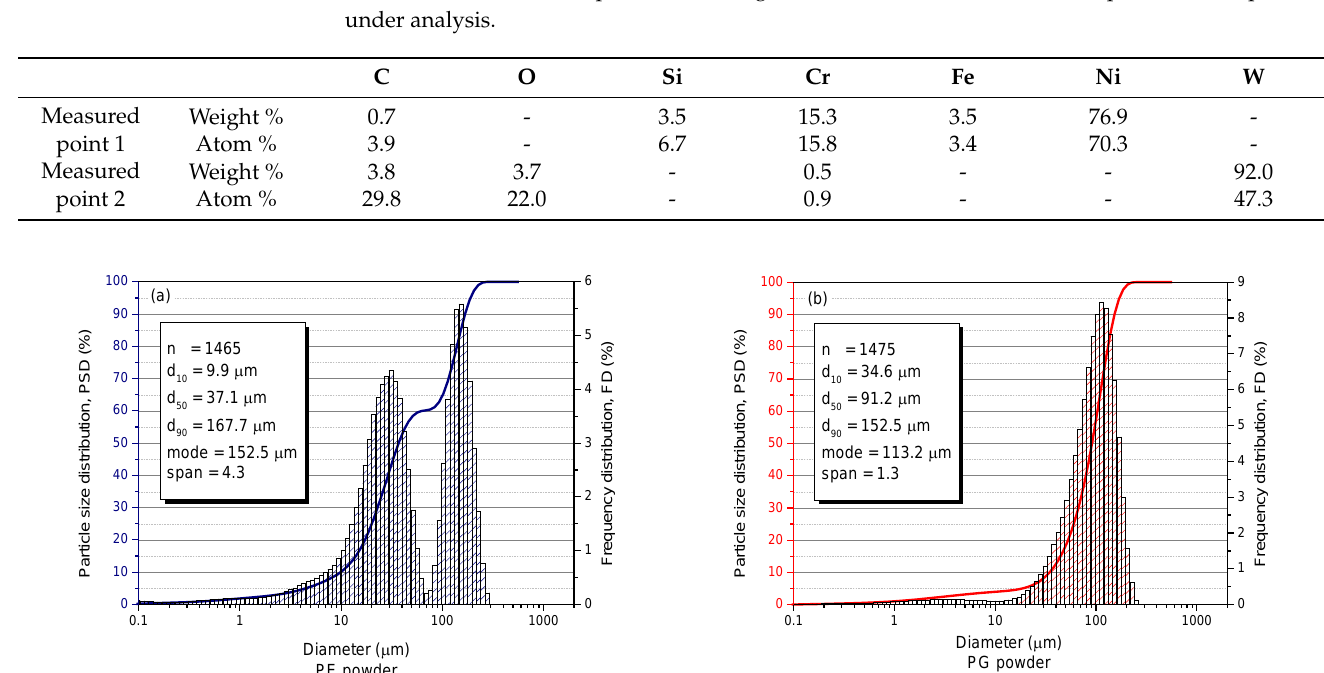
Figure 8. Cross-section of deposited surface layer of sample 1-PE showing the subsurface of the layer, middle zone, dilution zone, and HAZ.